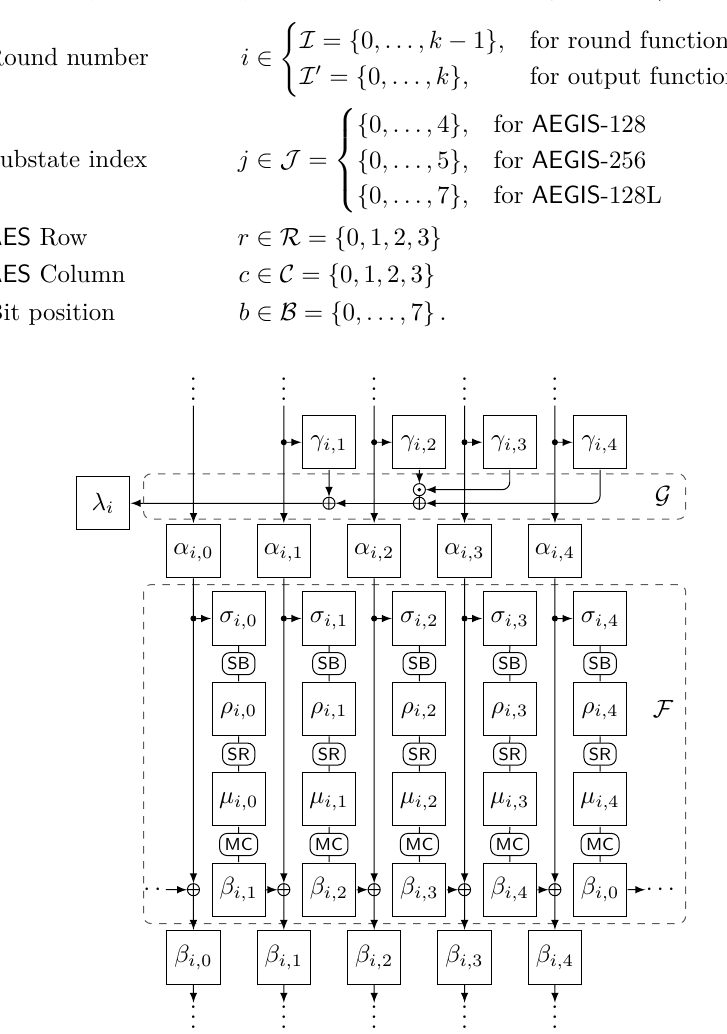
Figure 3: Notation for linear substate masks in round i of AEGIS